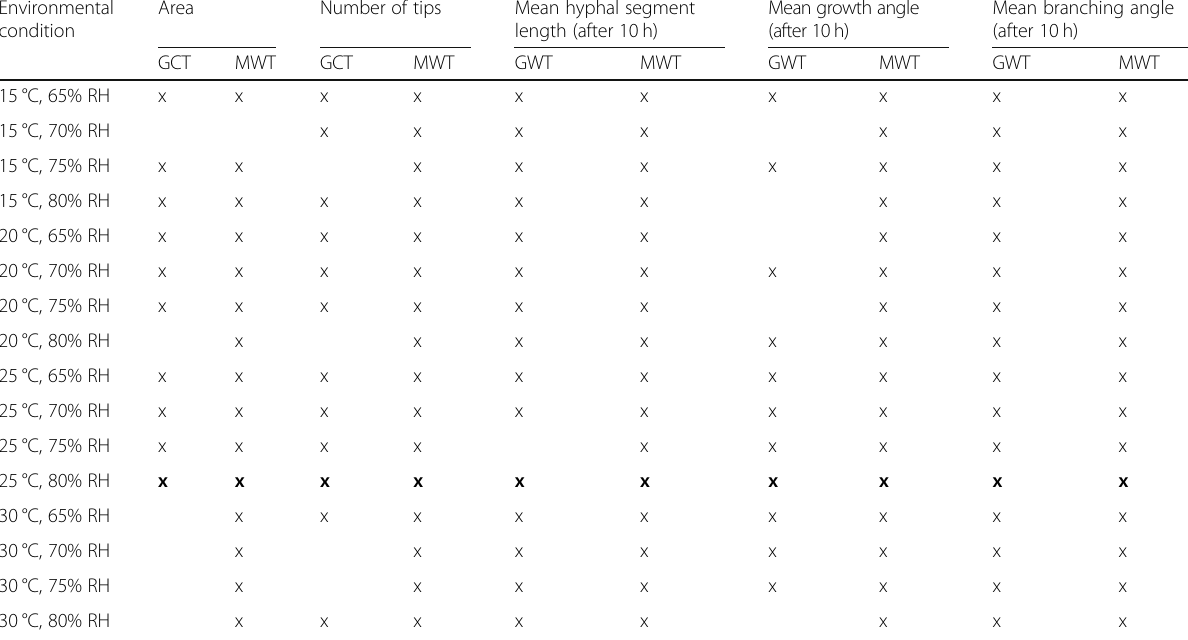
Table 2 Comparison of growth characteristics of C. puteana and R. solani for 16 combinations of temperature and RH Environmental Area Number of tips condition